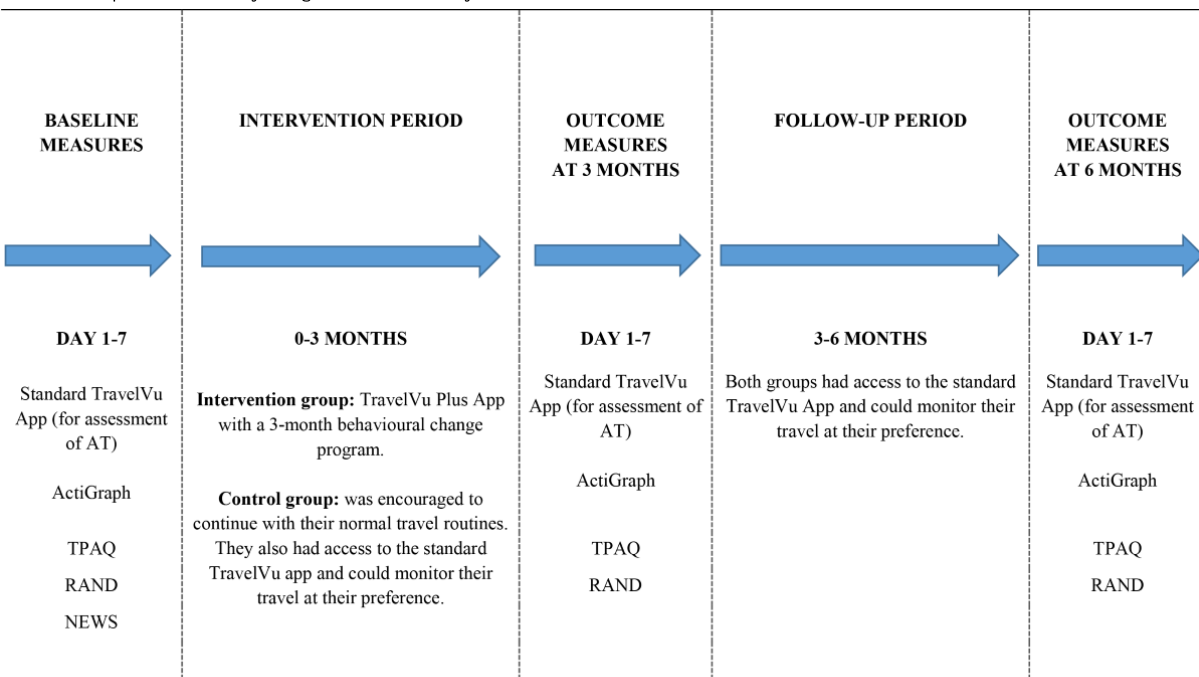
Figure 1. Description of the study design of the Smart City Active Mobile Phone Intervention